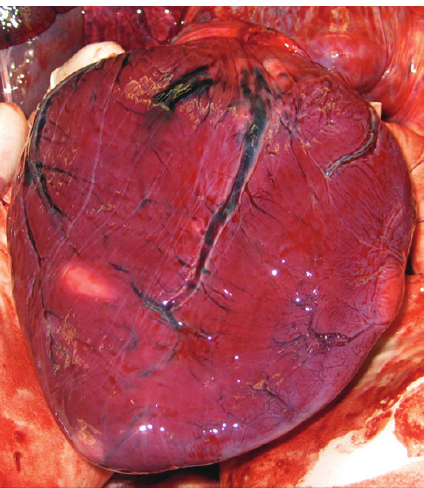
Figure 1: Heart; bearded seal. Multiple pale white discrete nodular masses expand the cardiac muscle